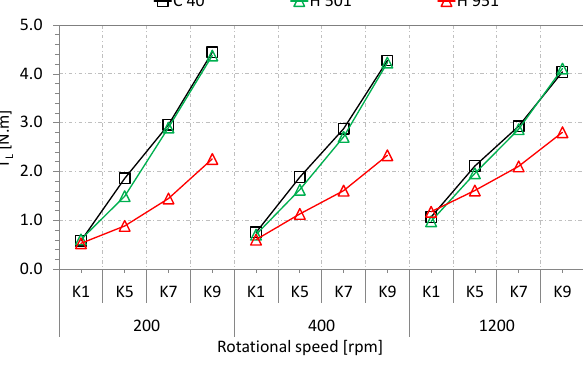
Table 2. Gear loss factor calculated according to different